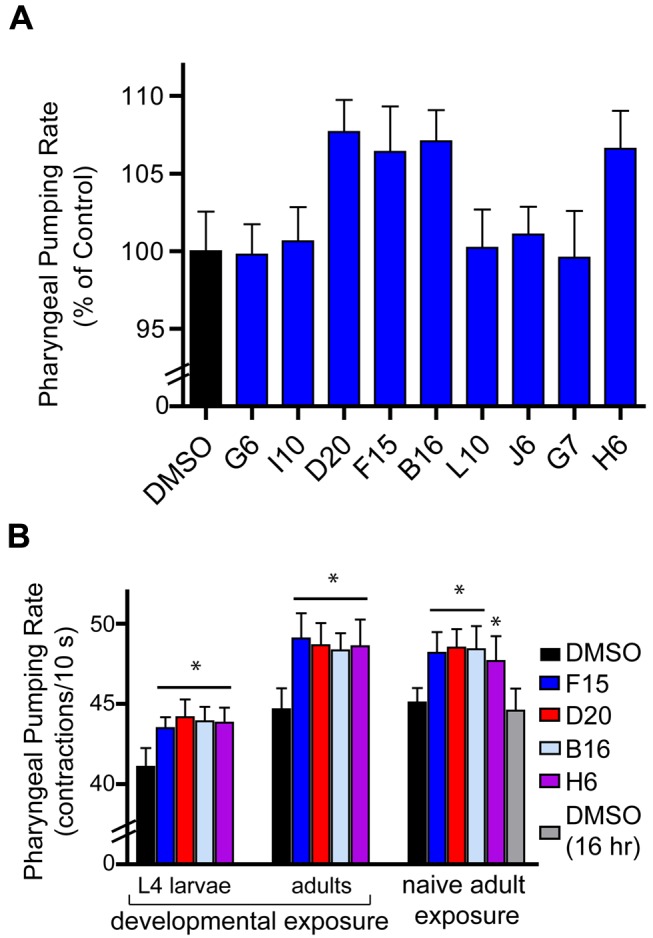
Several compounds with predicted and confirmed human targets increase pharyngeal pumping.(A) Wild-type C. elegans were cultured on media supplemented with either 0.1% DMSO (vehicle control) or 10 µM of each compound. (B) The effects of the compounds on the pharyngeal pumping rate when exposed for differing developmental periods was evaluated for C. elegans exposed to each 10 uM of each compound during different times: L1 to L4 (2 d at 20°C), L1 to gravid adult (3 d at 20°C, and naïve day 1 gravid adults exposed to B16, F15, and D20 for 1 h, H6 for 16 h). The pharyngeal pumping rate of 10–13 animals per condition was quantified. Error bars represent the standard deviation. *p<0.01: ANOVA, Dunnett's multiple comparisons test. In (B) gravid adults exposed to H6 for 16 h was compared to DMSO 16 h (t test: two tailed *p<0.01).